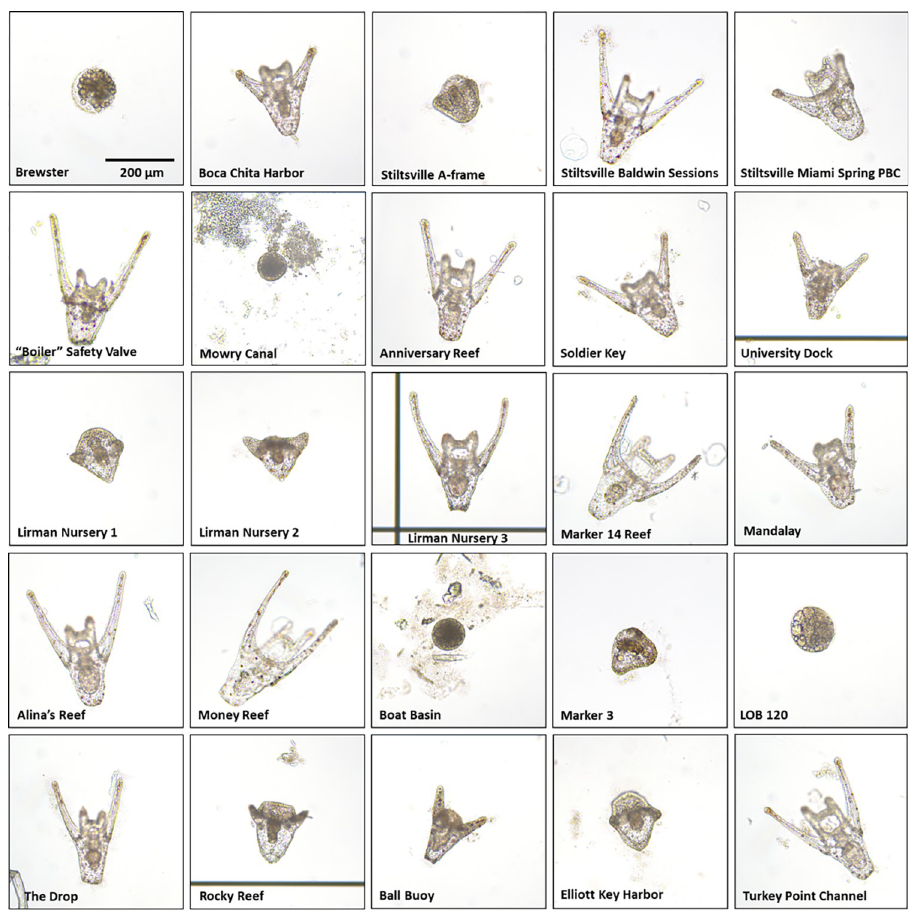
Fig 5. Representative sea urchin embryo images for each Biscayne National Park site. Magnification = 100x. All images are to scale.